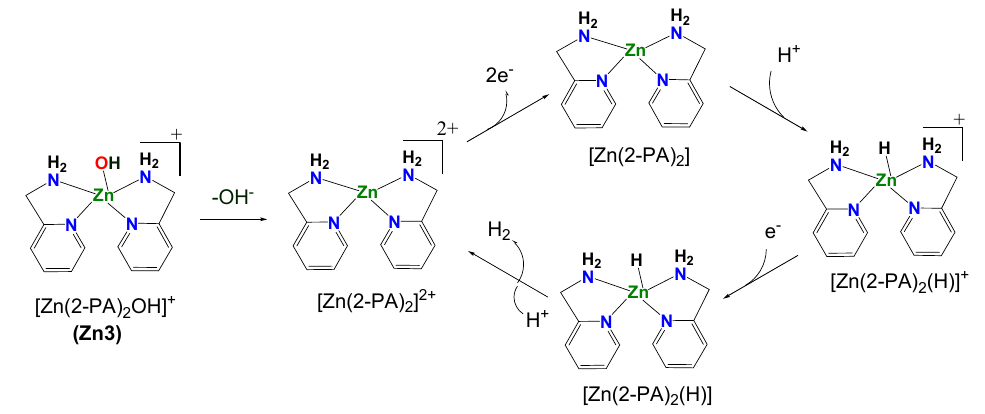
Scheme 2. A proposed catalytic mechanism for proton reduction by Zn3